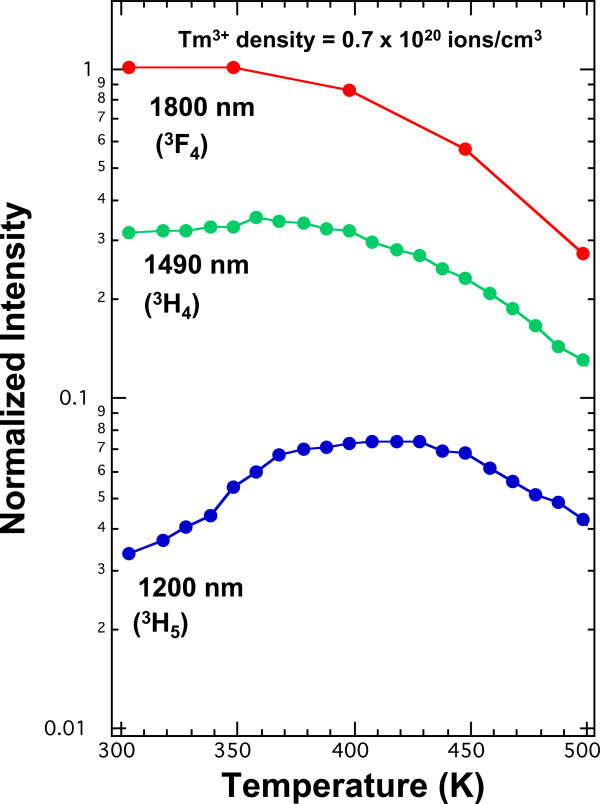
Temperature dependence of infrared fluorescence from Tm3+:YCl3. Normalized fluorescence intensity versus temperature between 300 and 500 K for Tm3+:YCl3. The fluorescence intensity of the 3 F4 level at 300 K is normalized to 1. The sample has a Tm3+ concentration of 0.7 × 1020 ions/cm3.